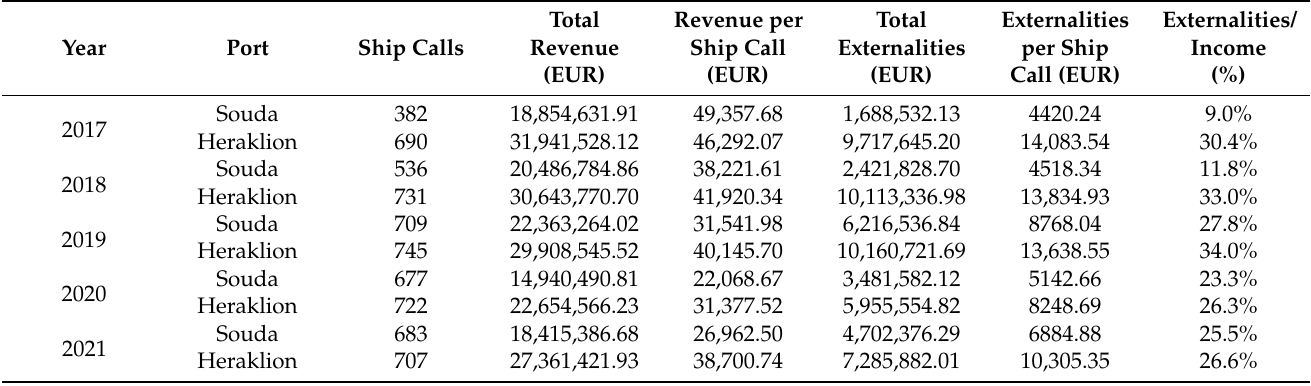
Table 7. Annual revenue and external costs for passenger ferries (ports of Souda and Heraklion).